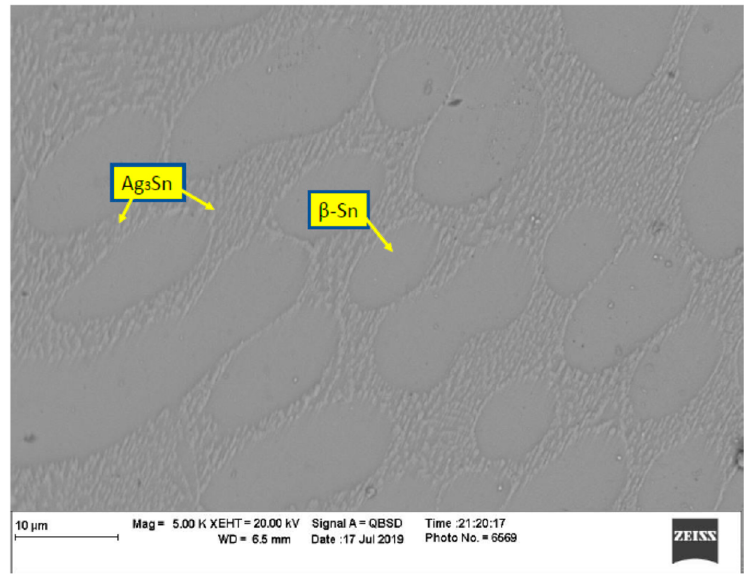
Figure 4. Microstructure of SAC305 as prepared (no aging).